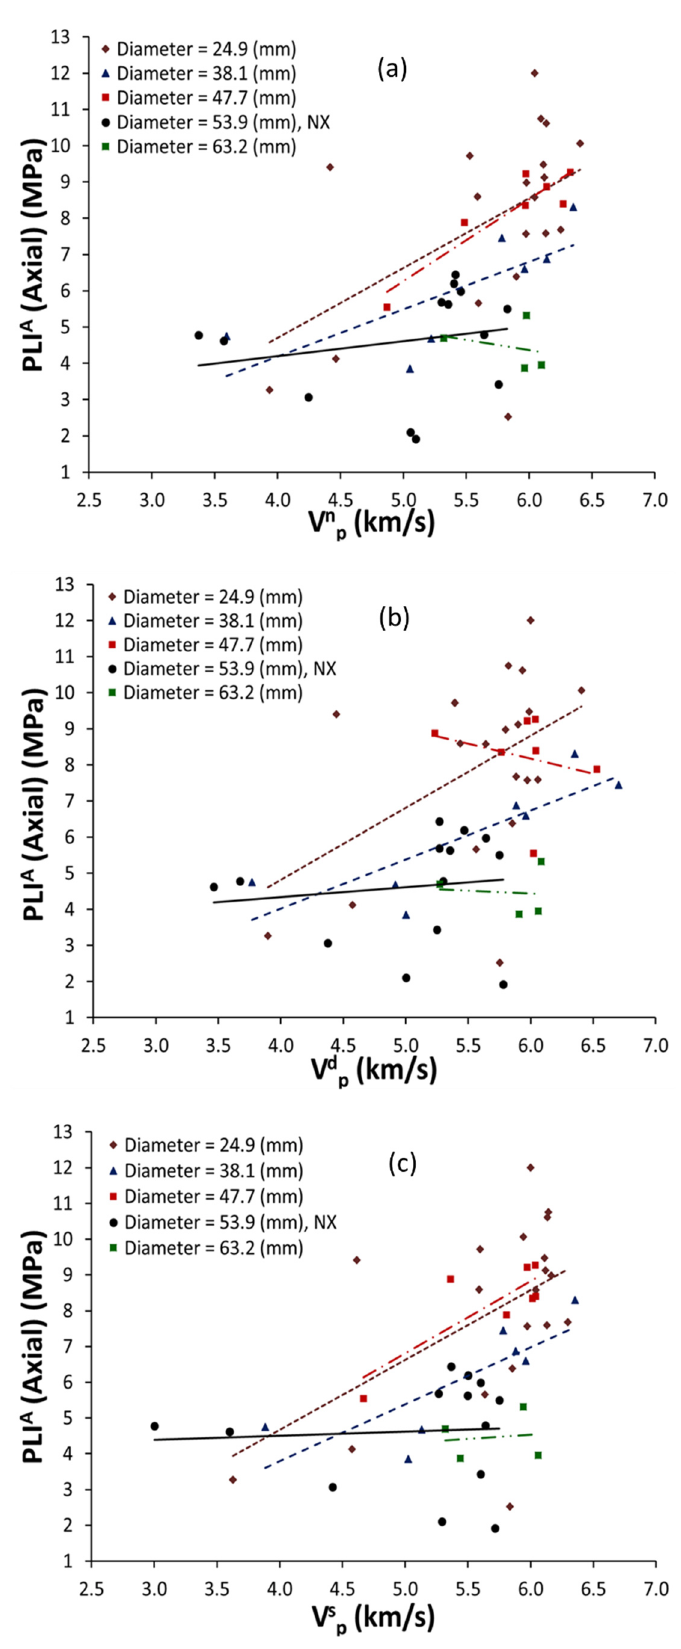
Figure 3. Variation in PLI A values. PLI A plotted as a function of ( a ) V np , ( b ) V dp , and ( c ) V sp for different sample diameters.